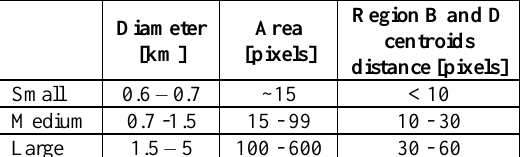
Table 4. Main features of the detected B and D region classes